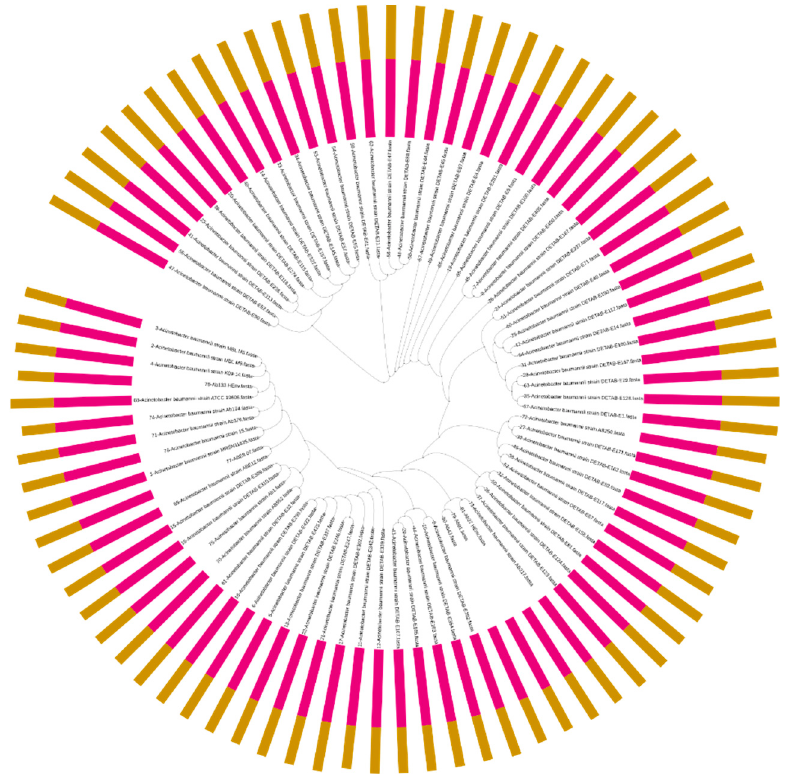
Figure 5. Multilocus ‐ typing ‐ and pangenome ‐ based phylogenetic analysis. The pink bars around the tree represent the fixed number of core genes, and the yellow type bars show the variating number of accessory genes.